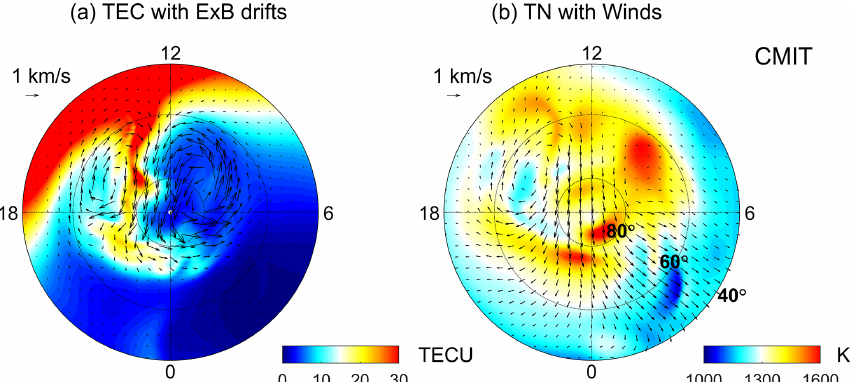
Figure 8. Polar maps of the (a) total electron content (TEC) and (b) neutral temperature simulated by CMIT as a function of geographic latitude and local time at 17:30UT on 17 March 2013. The vectors represent the (a) E × B drifts and (b) horizontal neutral